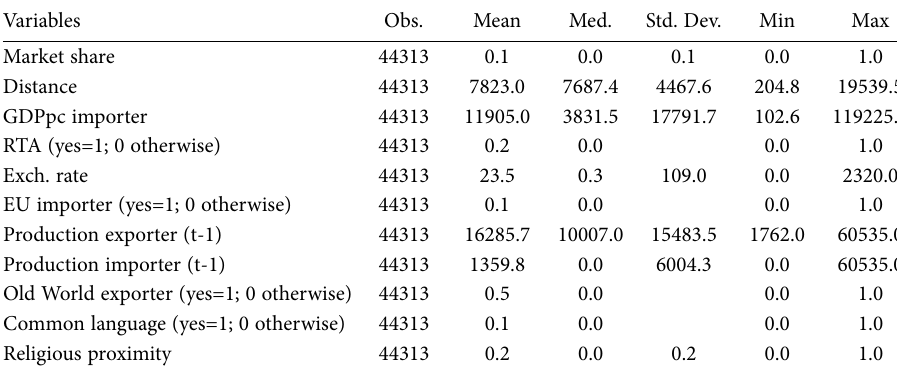
Table A.1. Descriptive